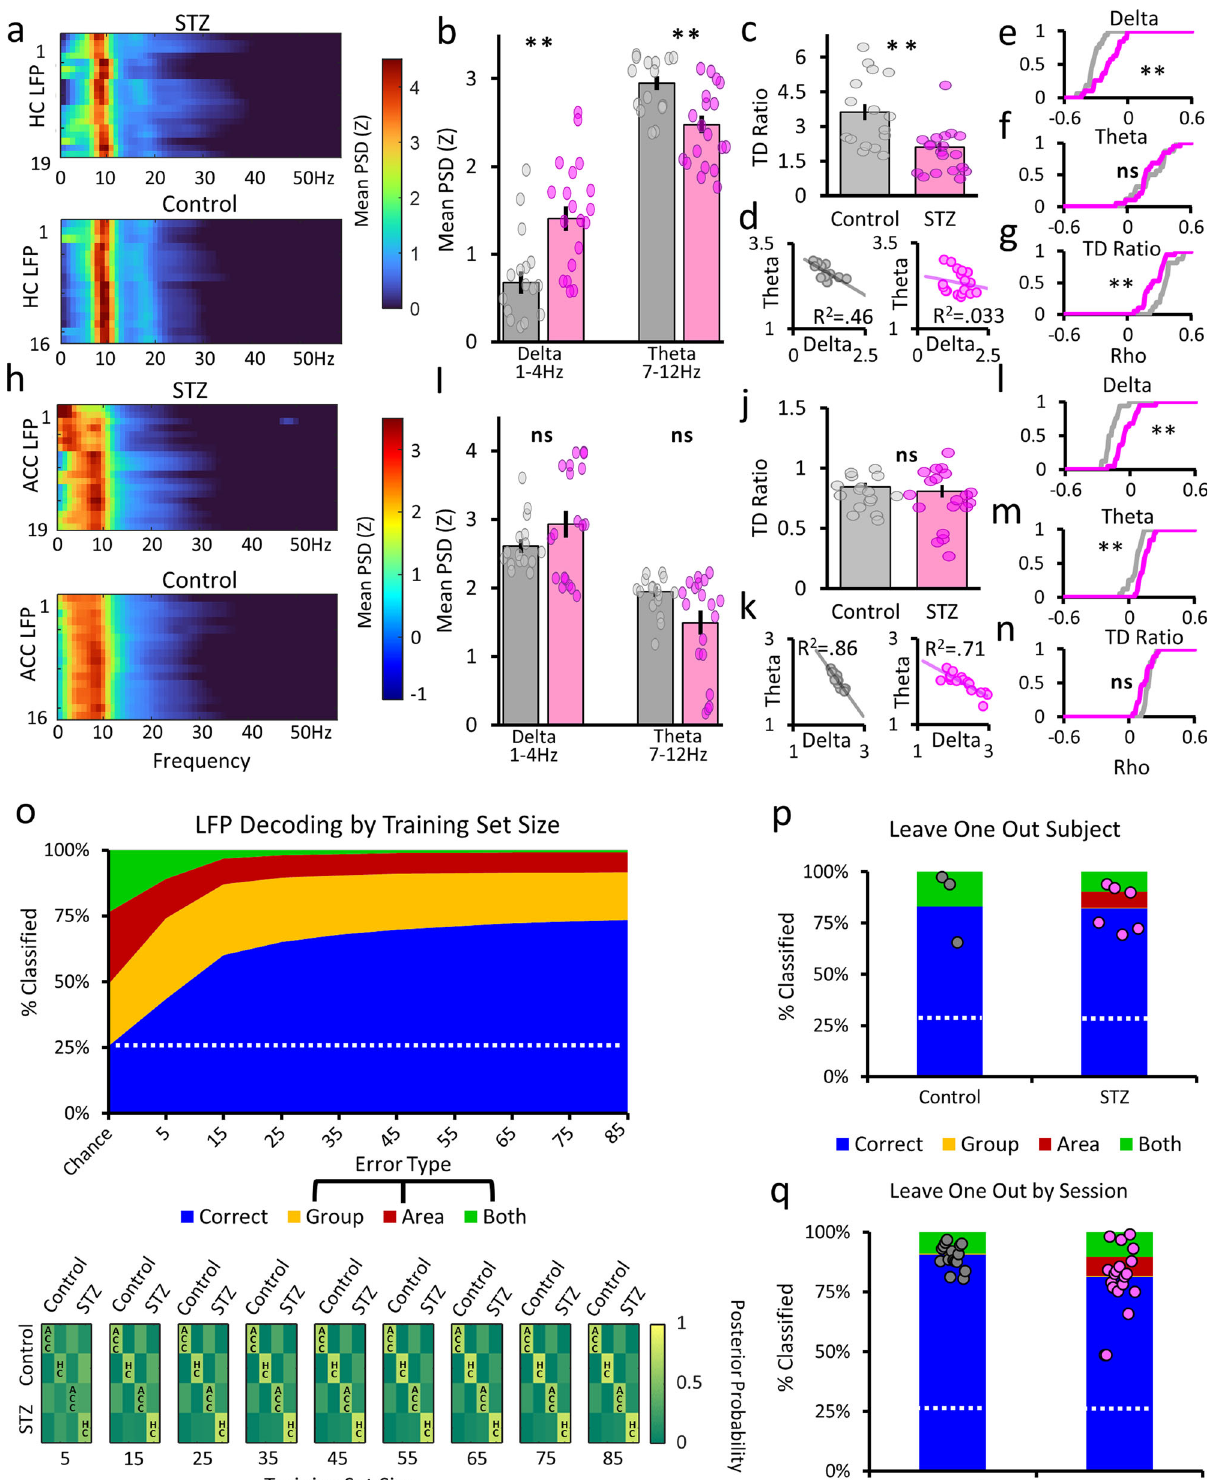
using methods from Mizuseki et al. 46 . We performed a two-way ANOVA on hippocampal sharp-wave ripple amplitude between groups and found no difference in STZ-treated or control animals ( F (1,33) = 0.305; p = 0.584), con fi rming that hippocampal recording locations were comparable across